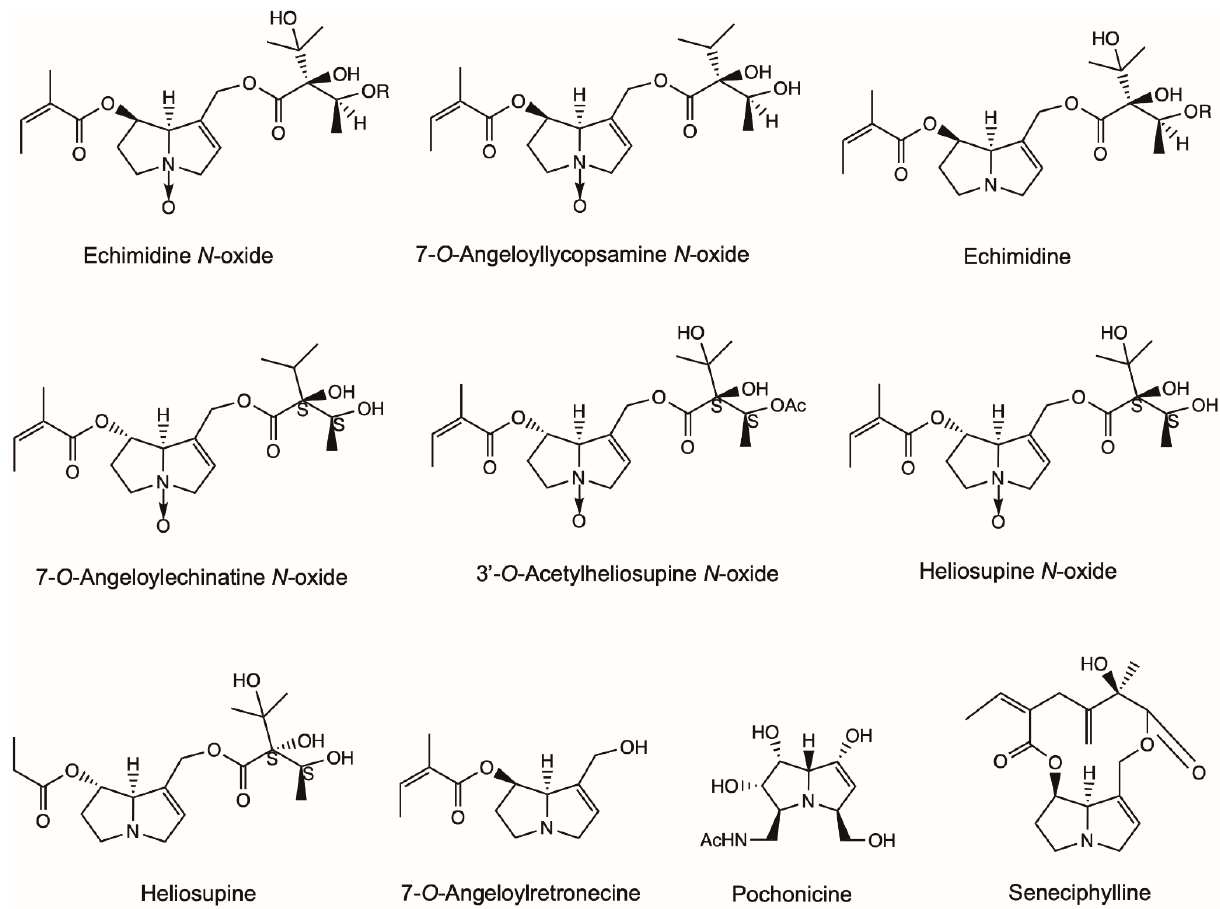
Figure 6. Structures of pyrrolizidine alkaloids (PAs) with acetylcholinesterase inhibitory activity and miscellaneous activity discussed in this review. Except seneciphylline and pochonicine, the other PAs represent the acetylcholinesterase inhibitors in this figure. Heliotrine, integerrimine, retrorsine, senecionine and usaramine also had anti-ulcer effects and were listed in Figure 1.